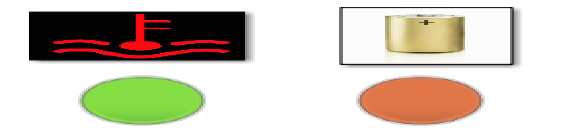
Figure A3. The code used in collecting data.